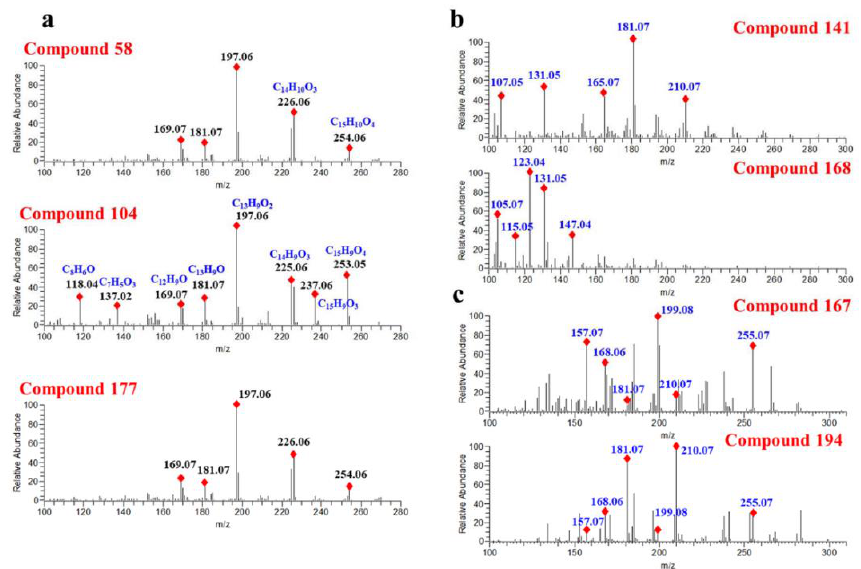
Figure 4. Fragment spectra of compounds annotated in Level 2b: ( a ) compounds annotated by Progenesis QI and ( b , c ) compounds annotated by Compound Discoverer.